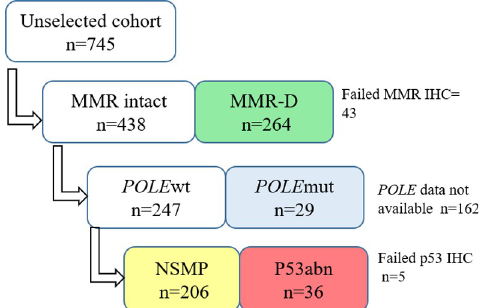
Fig 1. Molecular classification algorithm applied on 535 stage I-IV endometrioid endometrial carcinomas. MMR-D = mismatch repair deficient, wt = wild type, mut = mutated, NSMP = no specific molecular profile, abn =